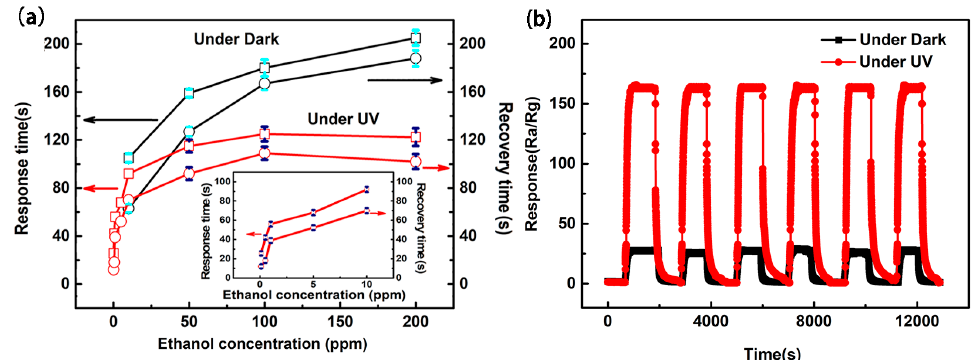
Figure 6. ( a ) The response and recovery times to different concentrations of C 2 H 5 OH and ( b ) six cycles of response curves to 100 ppm C 2 H 5 OH of the ZnO film sensors under dark and under UV light illumination.